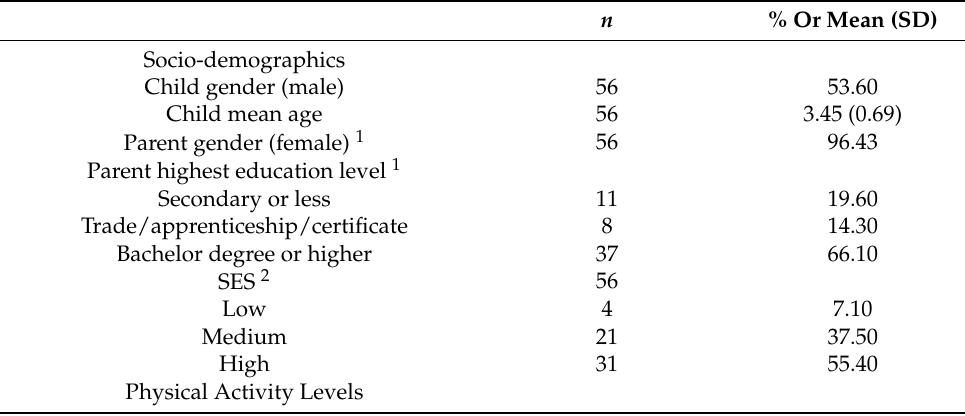
Table 1. Characteristics of study